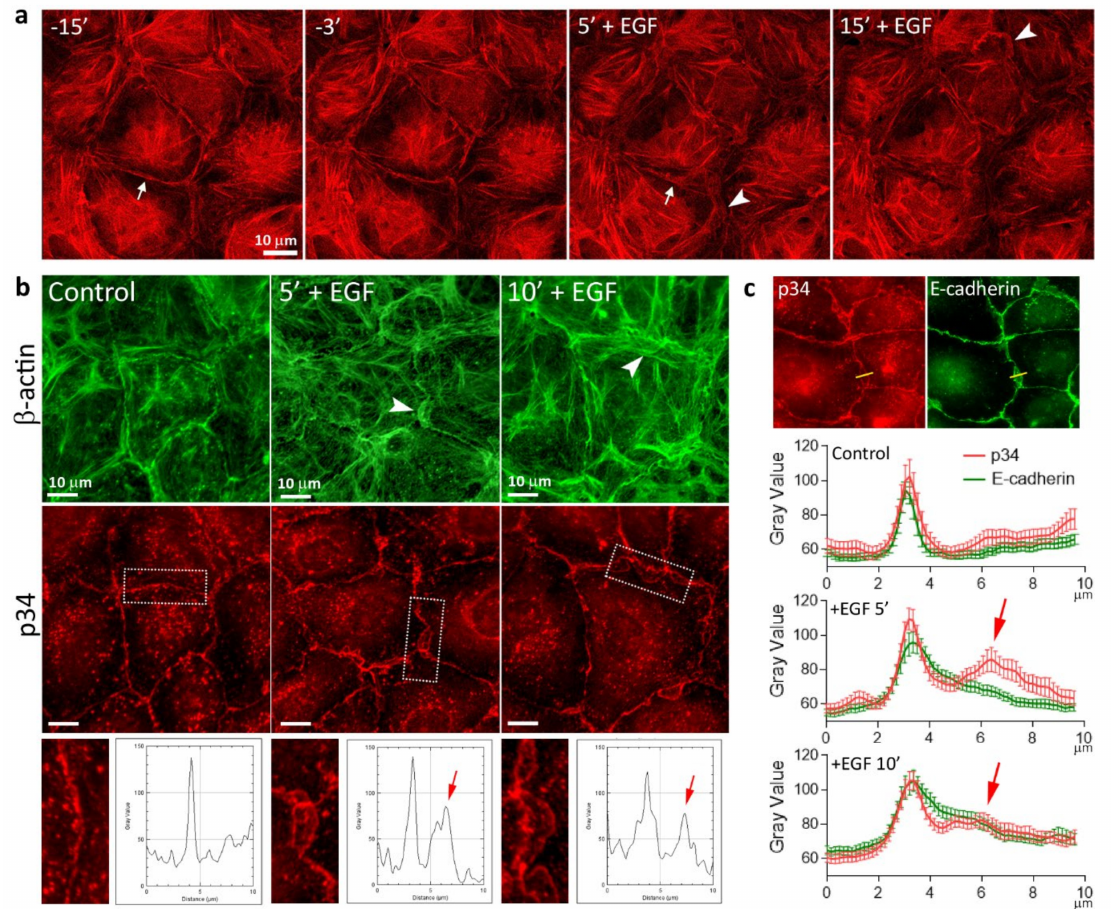
Figure 3. Reorganization of the actin cytoskeleton in IAR-20 cells treated with EGF. ( a ) Disruption of the circumferential actin bundle (arrow) and appearance of pseudopodia at the cell-cell-boundaries (arrowheads) after the addition of EGF in IAR-20 cells stably expressing F-tractin-tdTomato. Selected framesfromSupplementaryVideoS3. ( b )Immunostainingofp34and β -actin. Incontrolcells, theArp2 / 3 complex resides at cell-cell boundaries. In EGF-treated cells, Arp2 / 3 is enriched in lamellipodia close to cell-cell boundaries (arrowheads) where the disintegrated circumferential bundle is also seen. Dashed rectangles indicate the cell-cell boundaries enlarged in boxed regions with corresponding fluorescence intensity profiles. Arrows indicate p34 fluorescence intensity peak corresponding to the pseudopodia edge. ( c ) Immunostaining of p34 and E-cadherin (Figure S1) and corresponding fluorescence intensity profiles. In control cells, p34 colocalizes with E-cadherin. In EGF-treated cells, a second, smaller peak of p34 intensity appears which corresponds to the extending edges of the pseudopodia